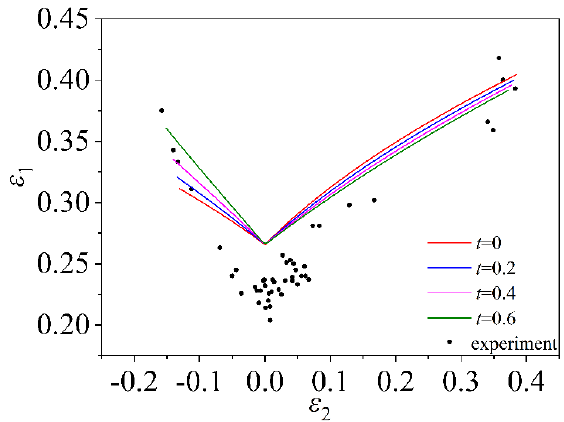
Figure 20. Stress-strain curve of material TRIP780.